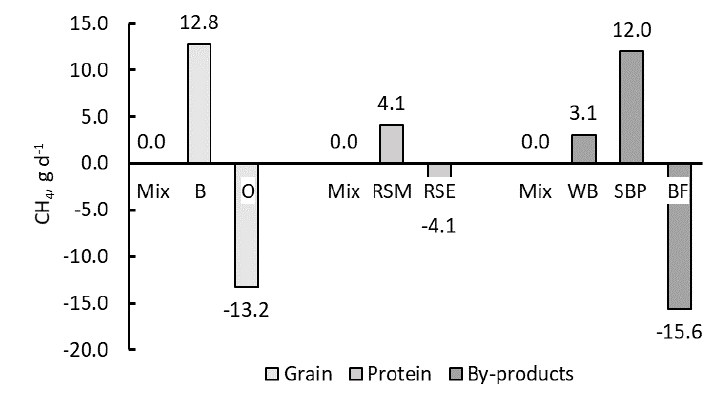
Fig. 5. Sensitivity analyses of the effects of concentrate ingredients on CH The values are deviations from the mean simulated value (434 g d -1 ) when only a single ingredient in feed category was used instead of mixtures. Feed ingredients: B = barley, O = oats, RSM = rapeseed meal, RSE = rapeseed expeller, WB = wheat bran, SBP = sugar beet pulp and BF = barley